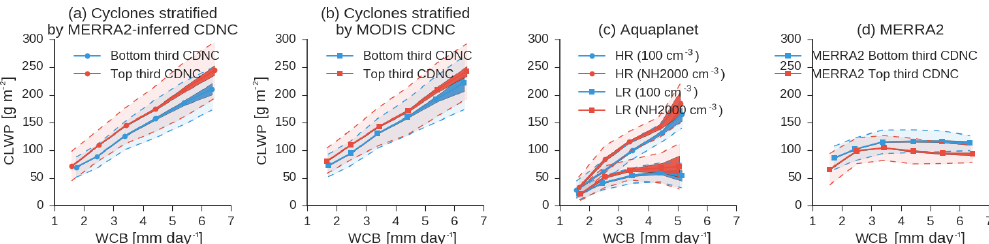
Figure 6. Comparison between the dependence of cyclone-mean liquid water path (CLWP) on warm conveyor belt (WCB) moisture flux as a function of increasing aerosol. The CLWP is binned by WCB moisture flux. The standard deviations in CLWP across bins are shown as shading with a dashed border. The 95% confidence interval on the mean is shown as thick solid lines. Panels (a) and (b) show MAC-LWP observations from 2003 to 2015 stratified by (a) MERRA2-inferred CDNC SW and (b) stratified by observations of CDNC SW from MODIS. Panel (c) shows the simulated CLWP in a suite of global aquaplanet simulations split into low and high N acc simulations. In the aquaplanet simulations a high aerosol channel is added to the Northern Hemisphere to investigate the response of cyclone properties and surface N acc is noted in the legend. Aquaplanet simulations are run at convection-permitting (HR) and GCM-surrogate resolution (LR). Panel (d) shows MERRA2 total precipitable liquid stratified by MERRA2-inferred CDNC SW . In panel (a, b, d) cyclones with CDNC SW in the top and bottom third of retrieved CDNC SW (see Fig. 5) are indicated by red and blue lines.